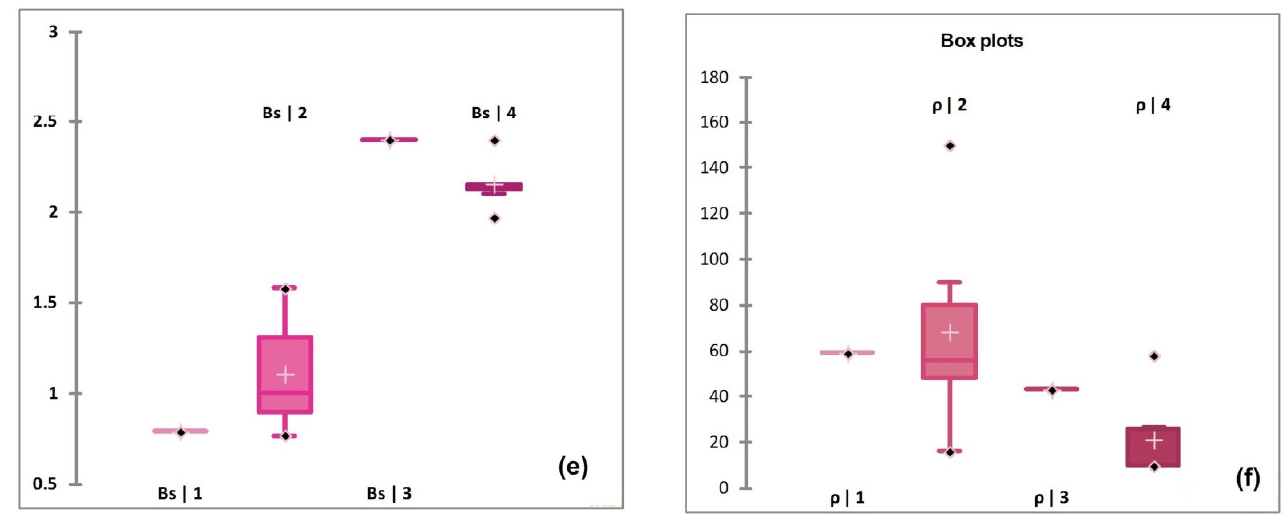
Figure 3. Box plots of ( a ) Tc; ( b ) μ max / μ o ; ( c ) Hc; ( d ) Br; ( e ) Bs; ( f ) ρ , for four clusters based on dendrogram.